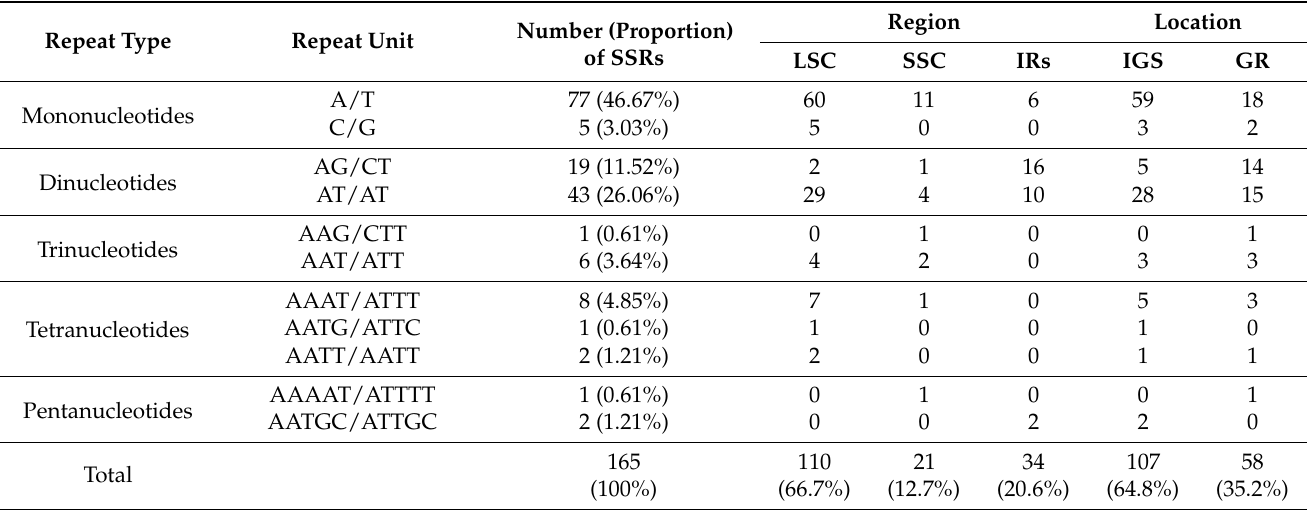
Table 3. Simple sequence repeats (SSRs) number in the chloroplast genome of Q. litseoides . Abbrevi- ations: LSC (Large Single Copy), SSC (Small Single Copy), IRs (Inverted Repeats), IGS (Intergenic Spacer Regions), GR (Gene